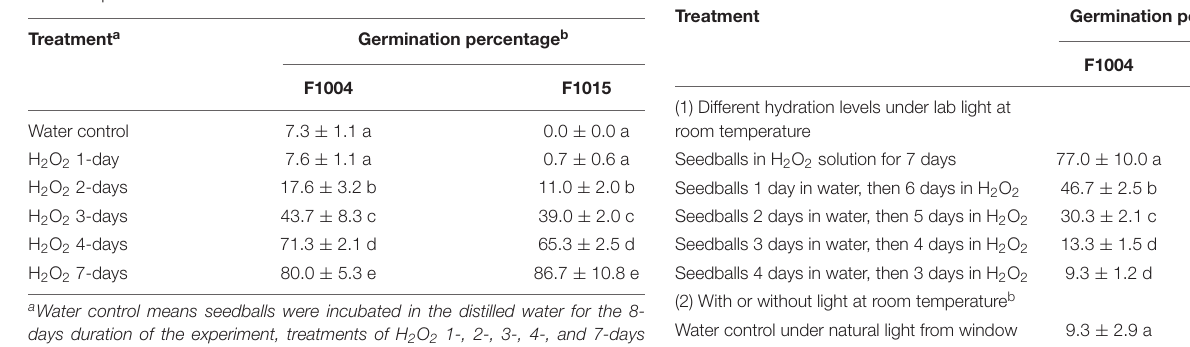
TABLE 2 | Seedball germination to determine effects of hydration, light, and temperature on germination induced by H 2 O 2